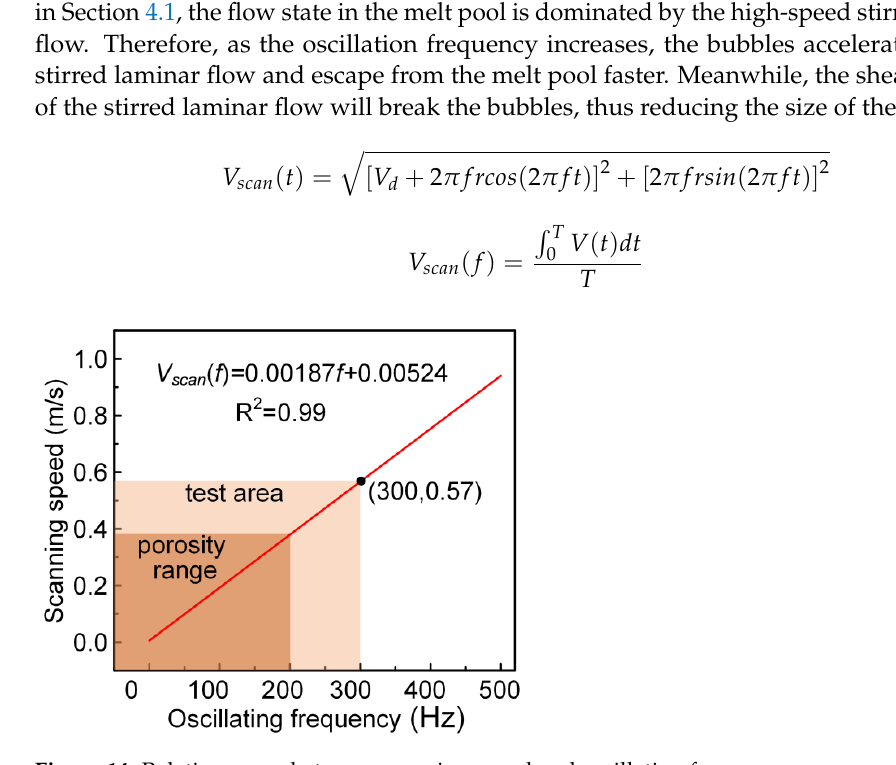
Figure 14. Relation curve between scanning speed and oscillating